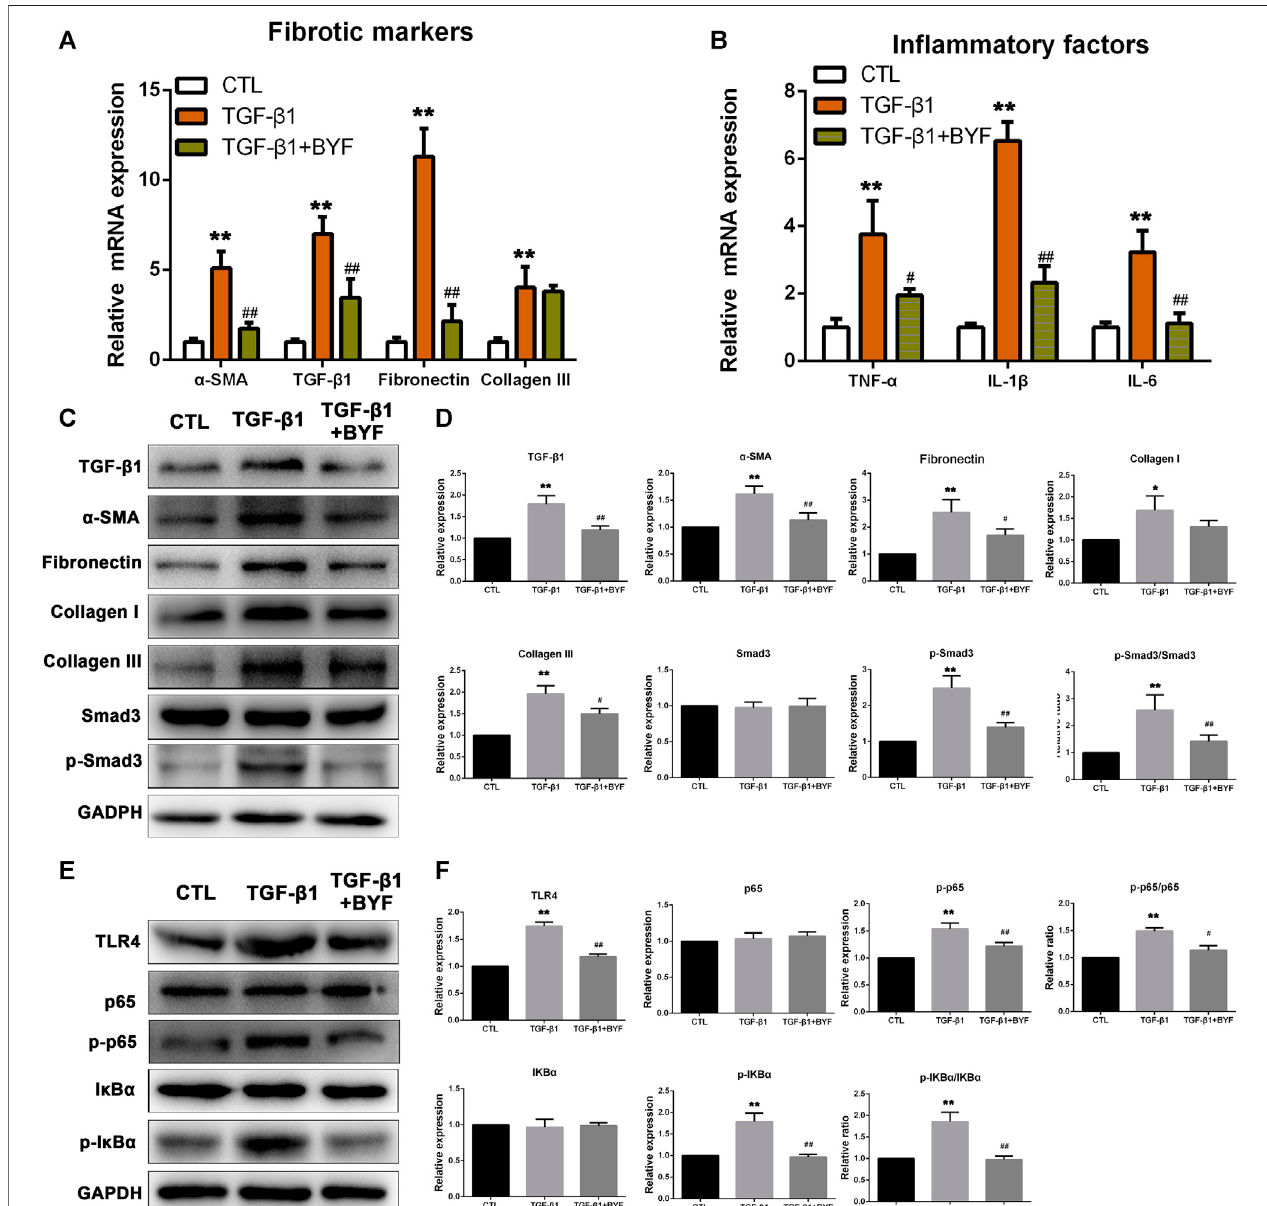
FIGURE6| BYFtreatment decreases fi broticand in fl ammatorymarkersexpression levels andinhibits TLR4/NF- κ Bsignaling pathway intheTGF- β 1-induced HK2 cells. qPCR validation of fi brotic markers (A) and in fl ammatory factors (B) between groups. Fibrotic markers WB validation (C) and quantitative analysis (D) in indicated groups. TLR4/NF-KB signaling main proteins WB validation (E) and quantitative analysis (F) in indicated groups. All values are presented as means ± SD. n (cid:1) 3 independent experiments for each indicator. * p < 0.05 and ** p < 0.01 vs. the CTL group; # p < 0.05 and ## p < 0.01 vs. the CKD group.